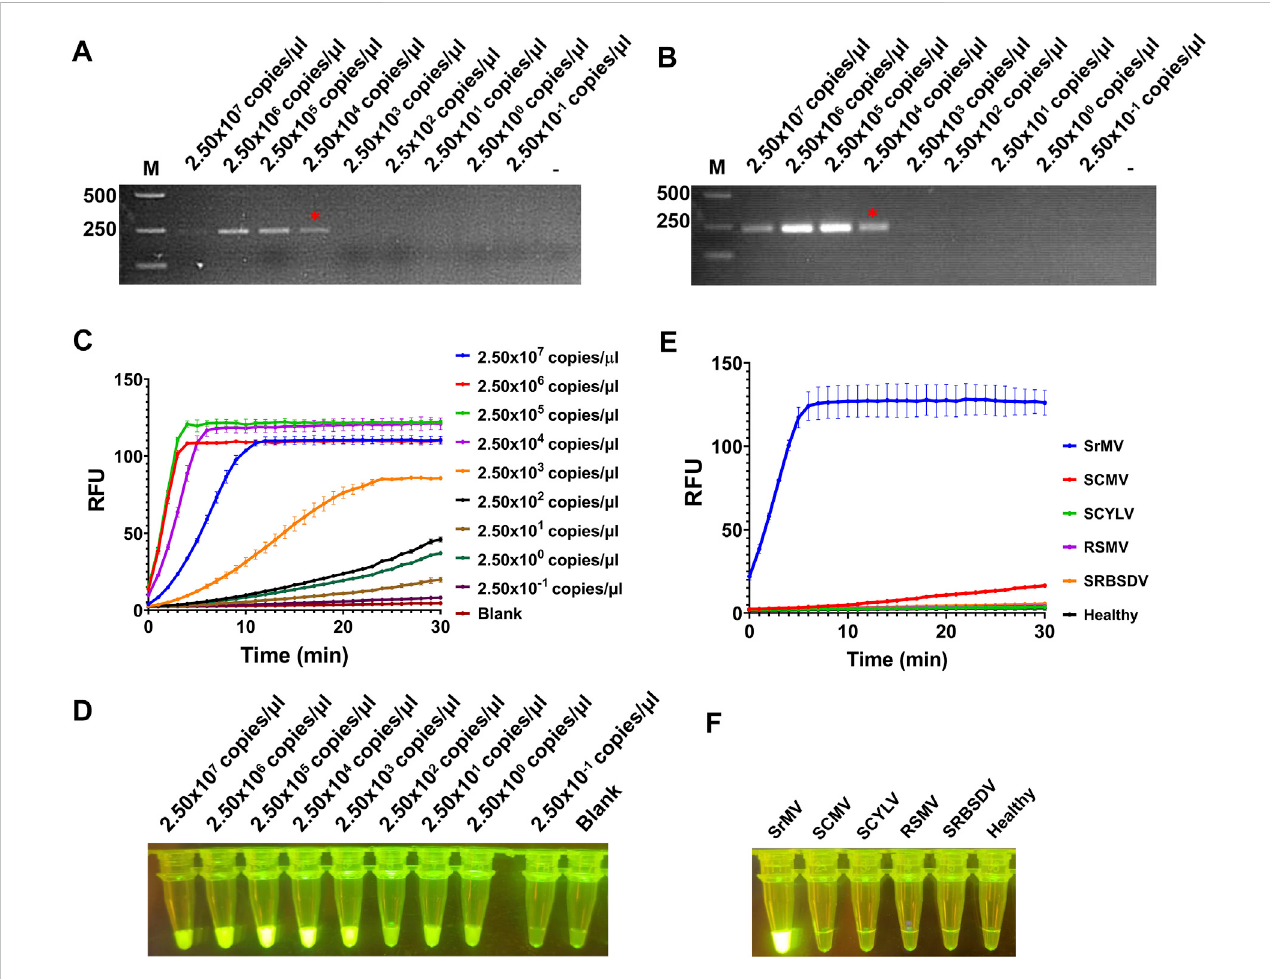
FIGURE 3 Sensitivity and speci fi city assay for RT-RAA-CRISPR/Cas12a detection for SrMV. (A) The crude extracts of SrMV infected sugarcane leaves were diluted gradiently and tested with RT-RAA. (B) The crude extracts were diluted gradiently and tested with RT-PCR. (C) The crude extracts were diluted gradiently and testedbyRT-RAA-CRISPR/Cas12adetection method,andthereal-time fl uorescencesignalwascontinuouslymonitoredfor30 min.Waterwasusedasblank control. (D) The gradiently diluted crude extracts were tested by RT-RAA-CRISPR/Cas12a method and followed by visual observation. (E) The crude extractsofplantssamplesinfectedwithdifferentvirusesweretestedbyRT-RAA-CRISPR/Cas12adetectionmethod,andthereal-time fl uorescencesignalwas continuously monitored for 30 min. Healthy plant sample was used as control. (F) The crude extracts of plants samples infected with different viruses were tested by RT-RAA-CRISPR/Cas12a method and followed by visual observation. SrMV: sorghum mosaic virus, SCMV: sugarcane mosaic virus, SCYLV: sugarcane yellow leaf virus, RSMV: rice stripe mosaic virus, SRBSDV: southern rice black-streaked dwarf virus. n = 3 technical replicates, and data points are shown as mean ±